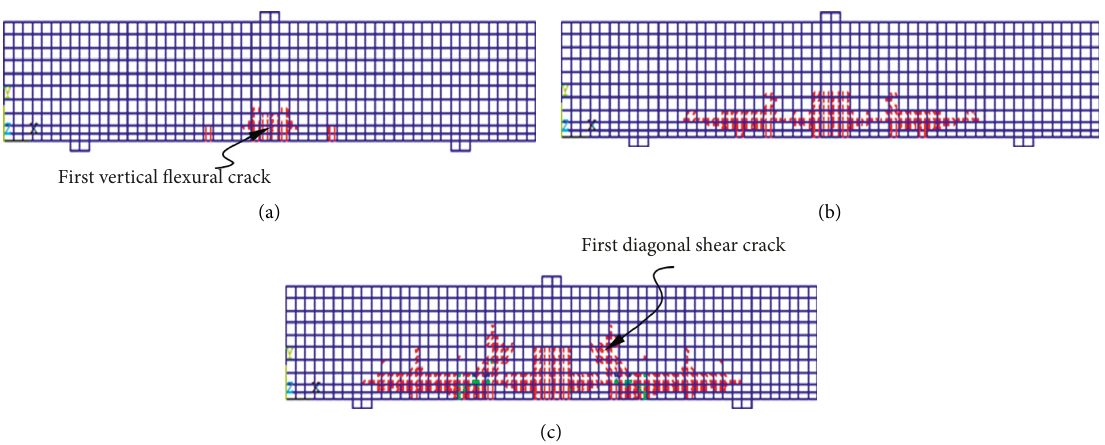
Figure 11: Evolution of FE cracks patterns in beam A2.5RC10/10 crack. (a) FE cracks at load 24.81kN. (b) FE cracks at load 34.07kN. (c) FE cracks at load 44.44kN.